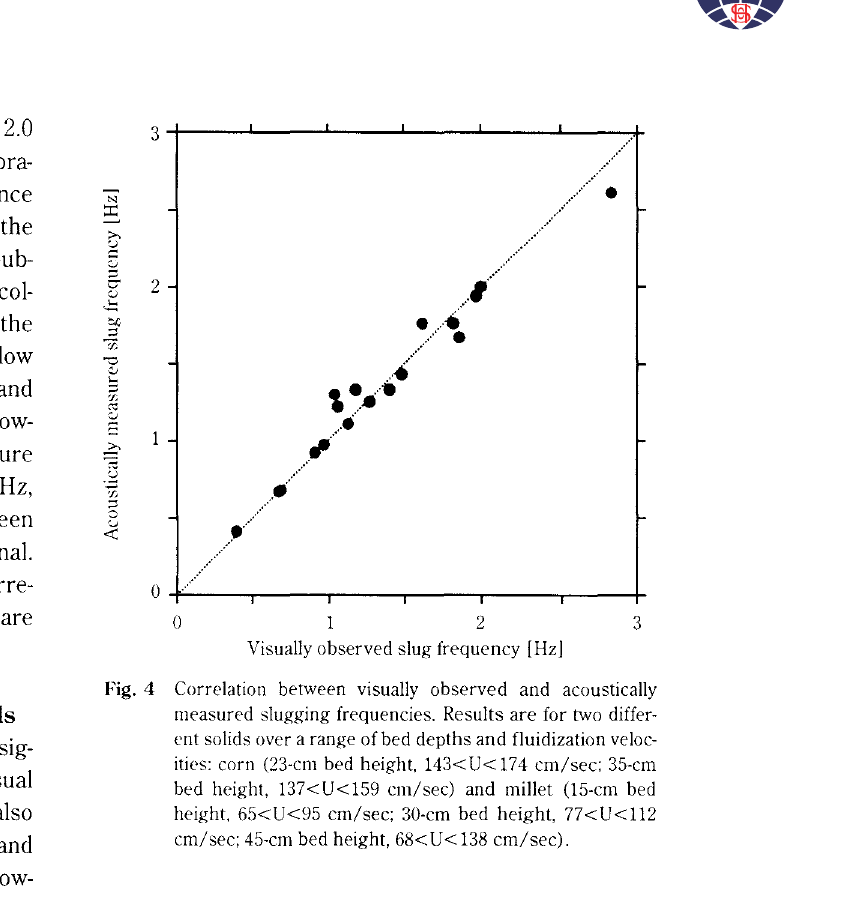
Fig. 4 Correlation between visually observed and acoustically measured slugging frequencies. Results are for two differ ent solids over a range of bed depths and fluidization veloc ities: corn (23·cm bed height, 143<U<174 em/sec; 35-cm bed height, 137<U<159 em/sec) and millet (15-cm bed height, 65<U<95 em/sec; 30-cm bed height, 77<U<112 em/sec; 45-cm bed height, 68<U<138